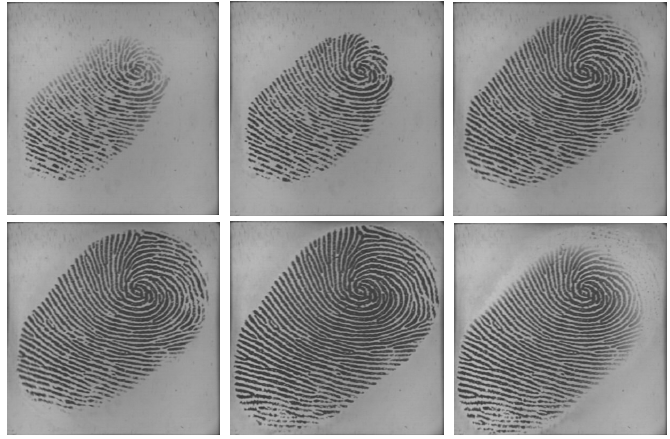
Figure 3. Six impressions in a fingerprint video. The fingerprint area of the first one enlarges gradually and, then, decreases.